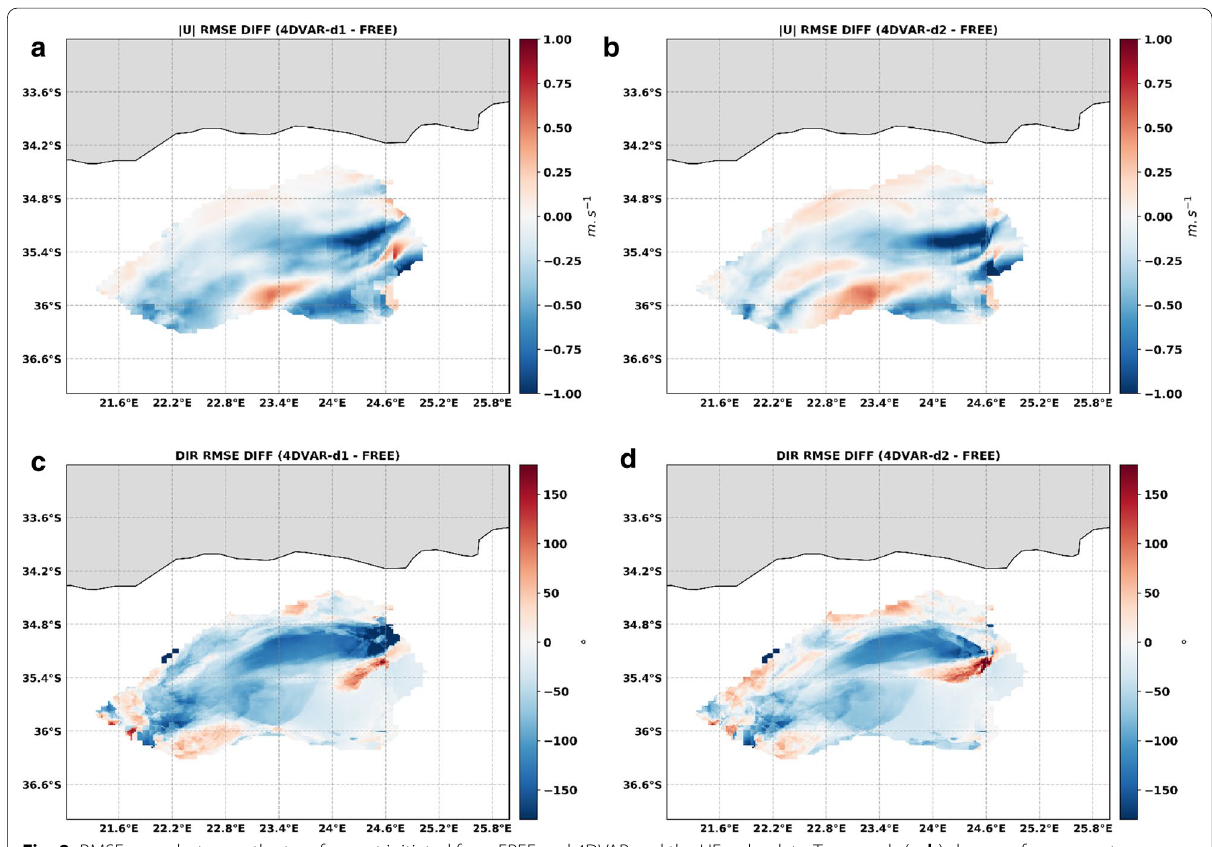
Fig. 8 RMSE maps between the two forecast initiated from FREE and 4DVAR and the HF radar data. Top panels ( a , b ) show surface currents intensities RMSE differences for the first ( a ) and the second ( b ) day of forecast. Surface currents directions RMSE differences for the first ( c ) and the second ( d ) day of forecast. Blue color means that the RMSE is reduced in the case of forecast issued from 4DVAR initial condition